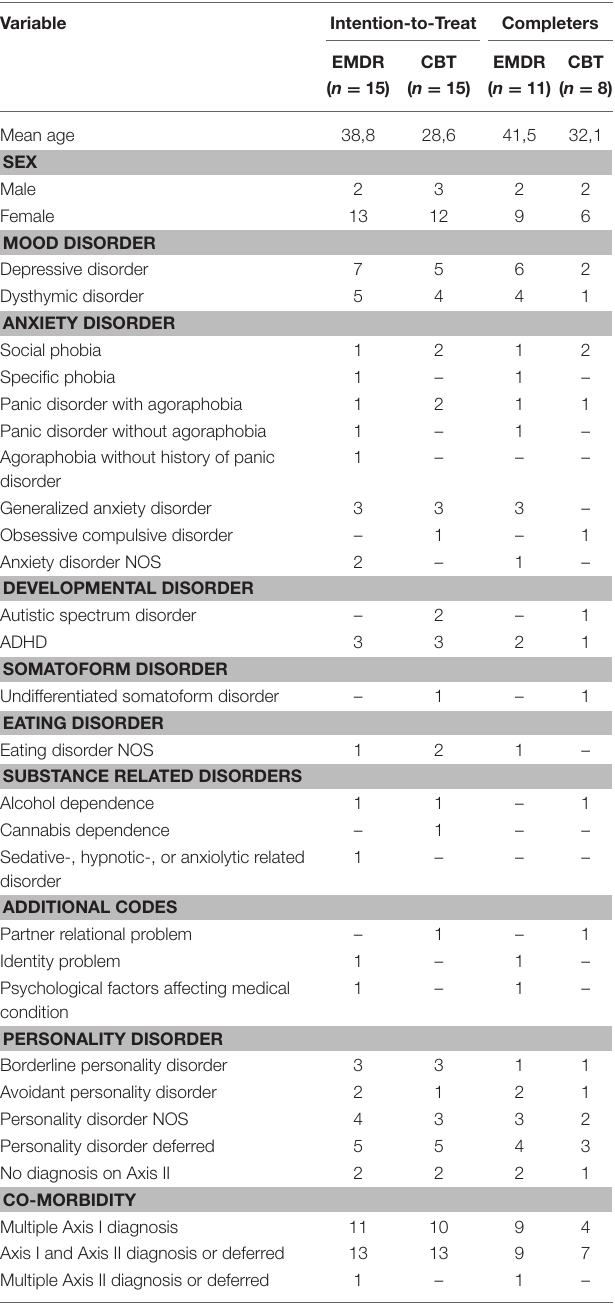
TABLE 1 | Demographic and Diagnostic Characteristics of Intention-to-Treat and Treatment Completer Samples, divided by group allocation.